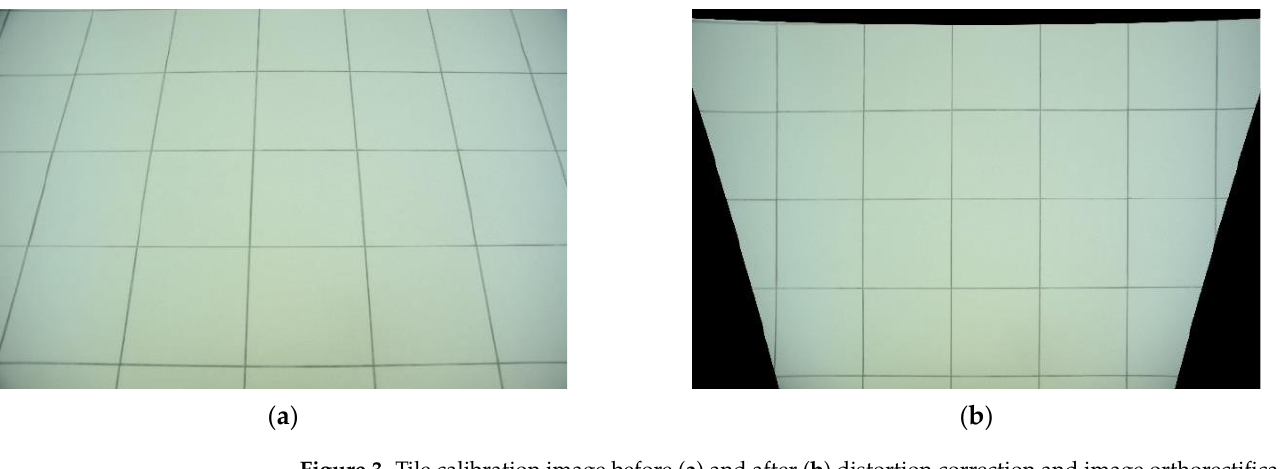
Figure 3. Tile calibration image before ( a ) and after ( b ) distortion correction and image orthorectification from oblique view with 𝛼 = 27° .